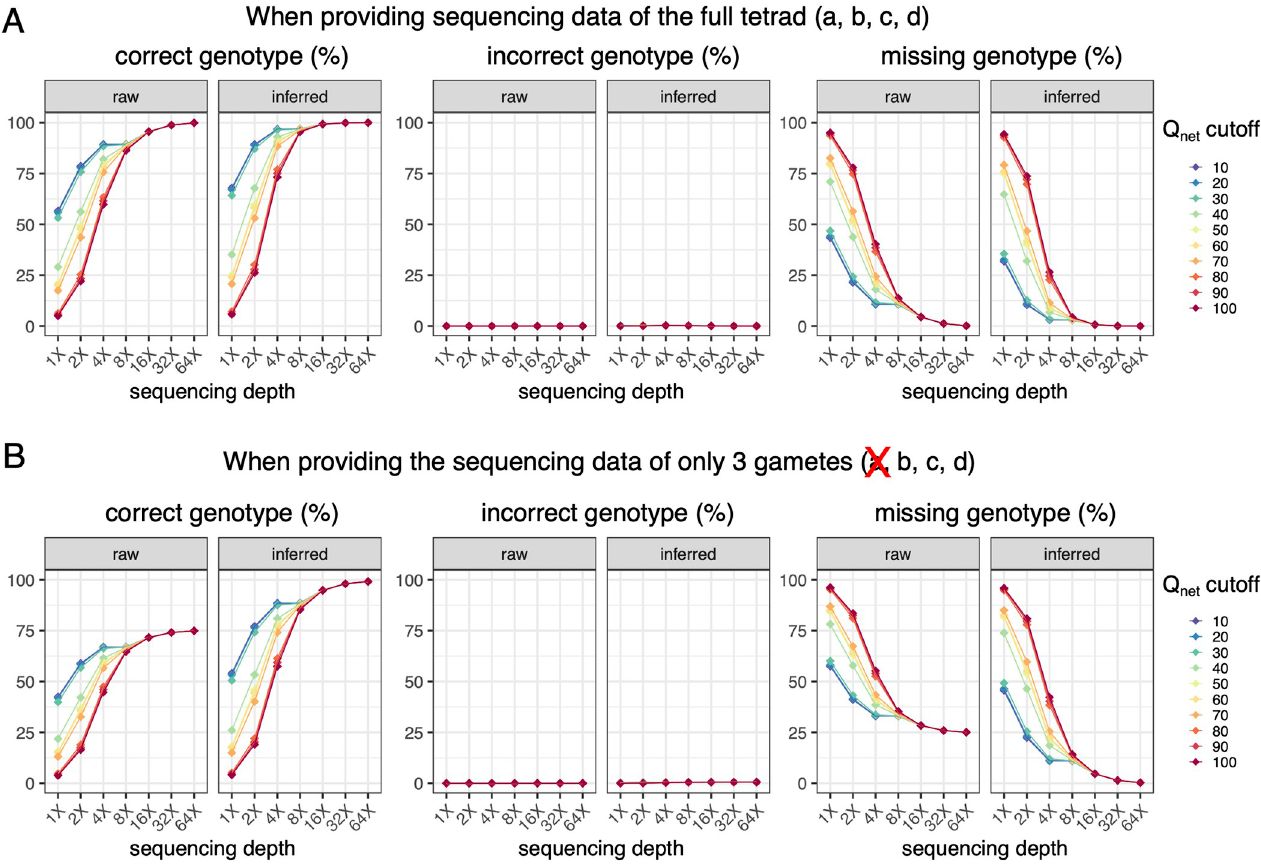
Fig 4. The benchmark of RecombineX’s genotyping accuracy. (A) The calculated percentage of correct, incorrect, and missing genotypes based on RecombineX’s gamete genotyping results in comparison to the simulated ground truth when the sequencing data of all four gametes (a, b, c, d) are provided. (B) The calculated percentage of correct, incorrect, and missing genotypes based on RecombineX’s genotyping results in comparison to the simulated ground truth when the sequencing data of only three gametes (b, c, d) are provided. For both panel A and panel B, the tested sequencing depths are 1X, 2X, 4X, 8X, 16X, 32X and 64X and the tested Q net cutoffs are 10, 20, 30, 40, 50, 60, 70, 80, 90,